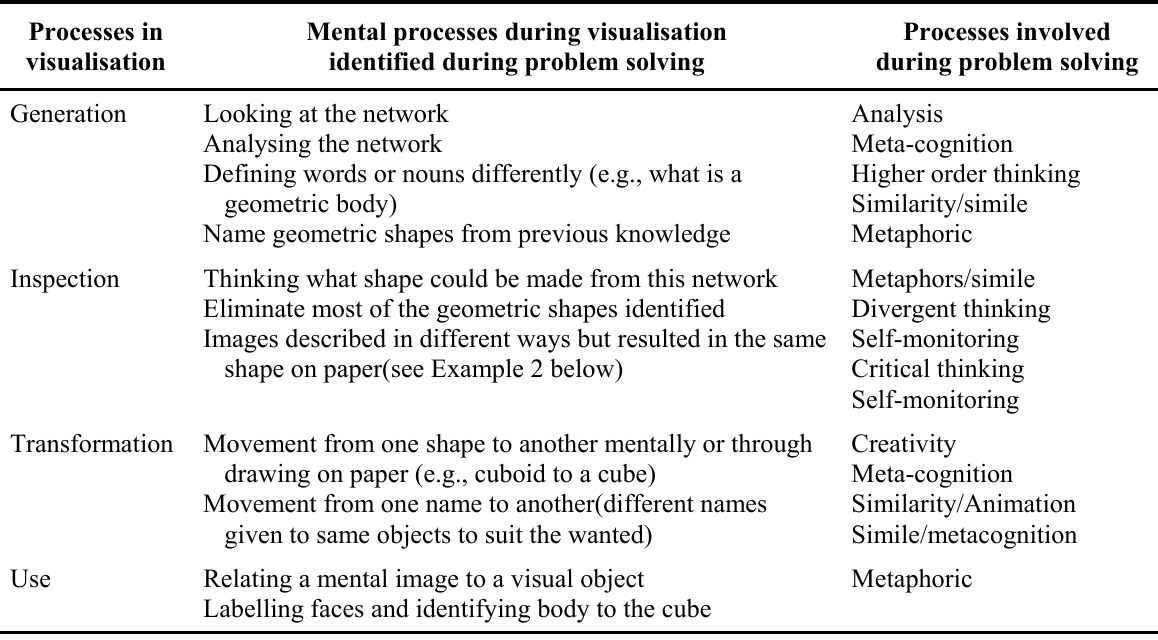
Table 1 : Results of Task